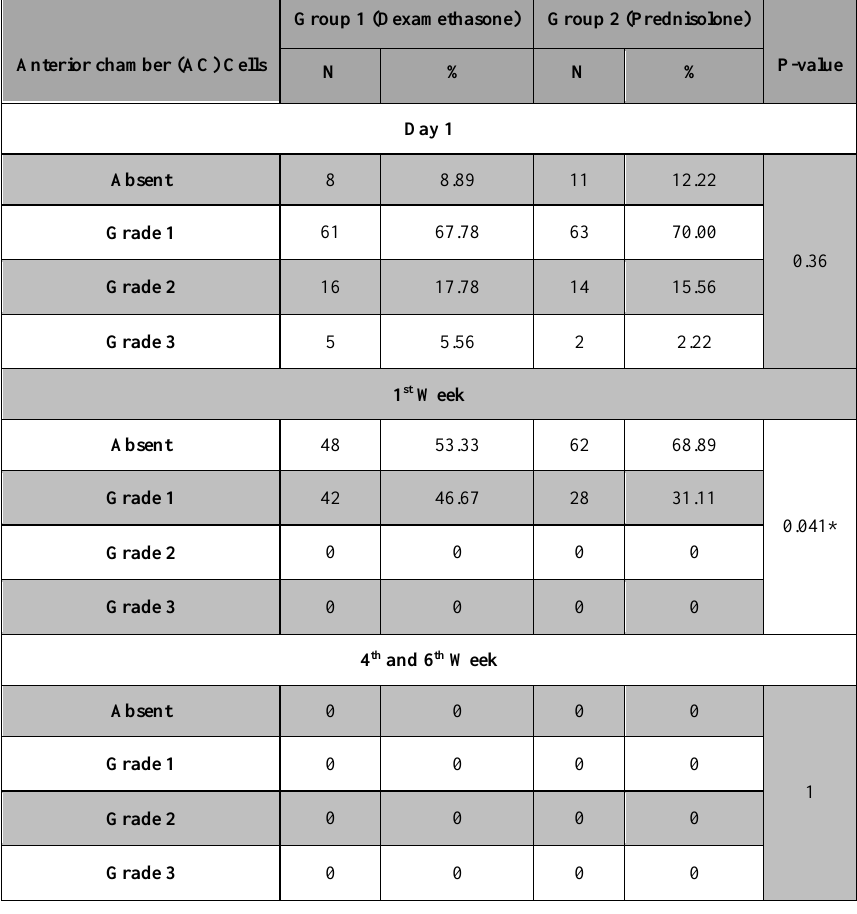
Table 3. Assessment of ac cells comparison among the study groups.